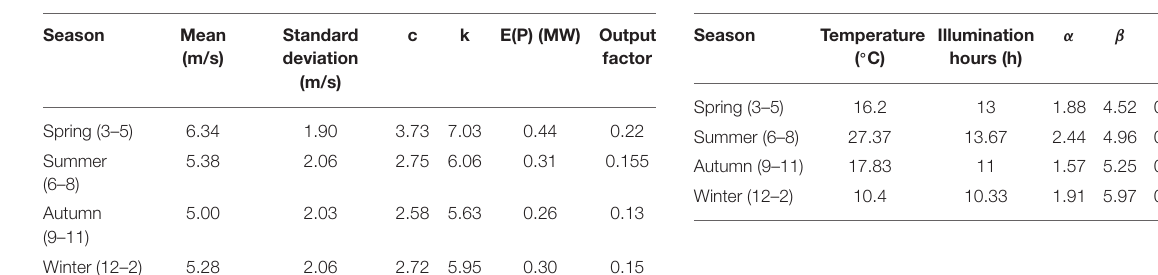
TABLE 4 | The output factor of wind power. TABLE 5 | The output factor of solar